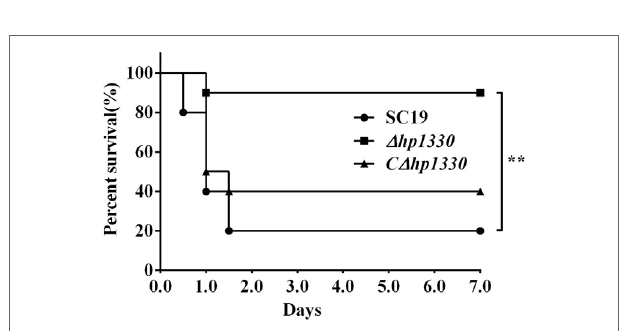
FigUre 6 | Survival curves of mice infected with SS2 strains. Female C57BL/6 mice in different groups were challenged i.p. with 6 × 10 8 colony-forming units SC19, Δ hp1330 , or C Δ hp1330 strains cultured on tryptic soy agar. The mortality of mice was recorded for 1 week. The results shown are representative of three independent experiments.